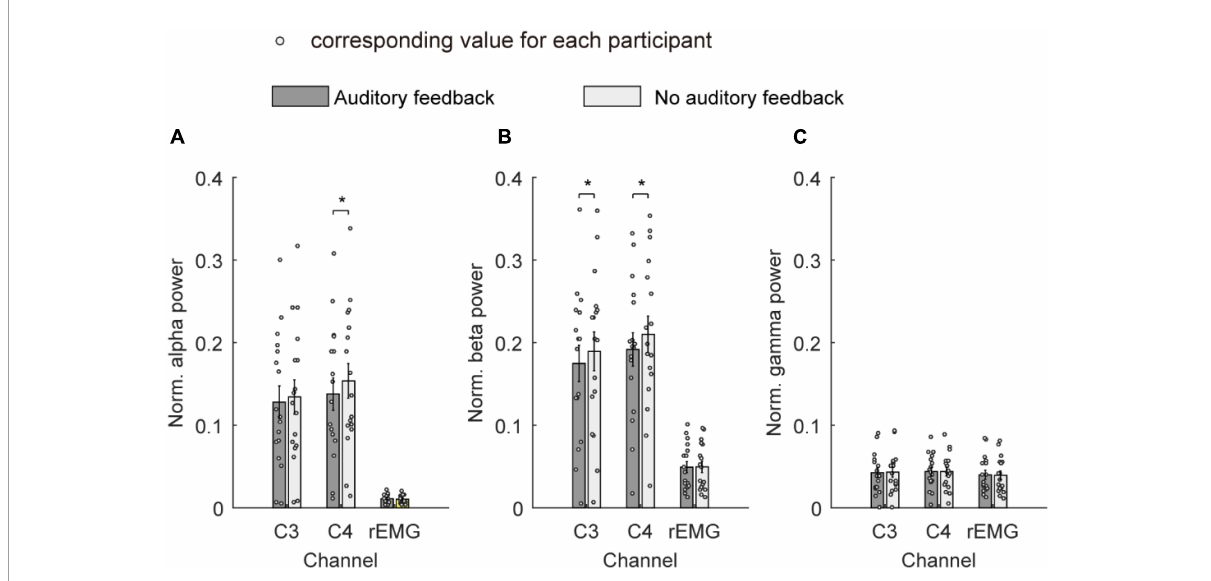
FIGURE6 The average normalized power spectrum of all the participants ( N = 17) in the alpha band (A) , the beta band (B) , and the gamma band (C) over channels C3, C4, and rEMG in auditory feedback and no auditory feedback conditions, the horizontal axis means the channel label, the vertical axis means the average normalized power spectrum. The empty circles mean the corresponding value for each participant. The data were presented as mean ± SEM. * p < 0.05. SEM, standard error of mean; rEMG, right